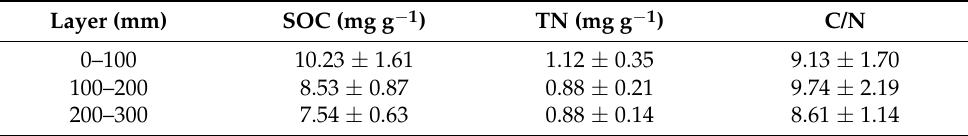
Table 1. Soil carbon and nitrogen contents of the lucerne grasslands in different depths. (Mean ± SD, n =